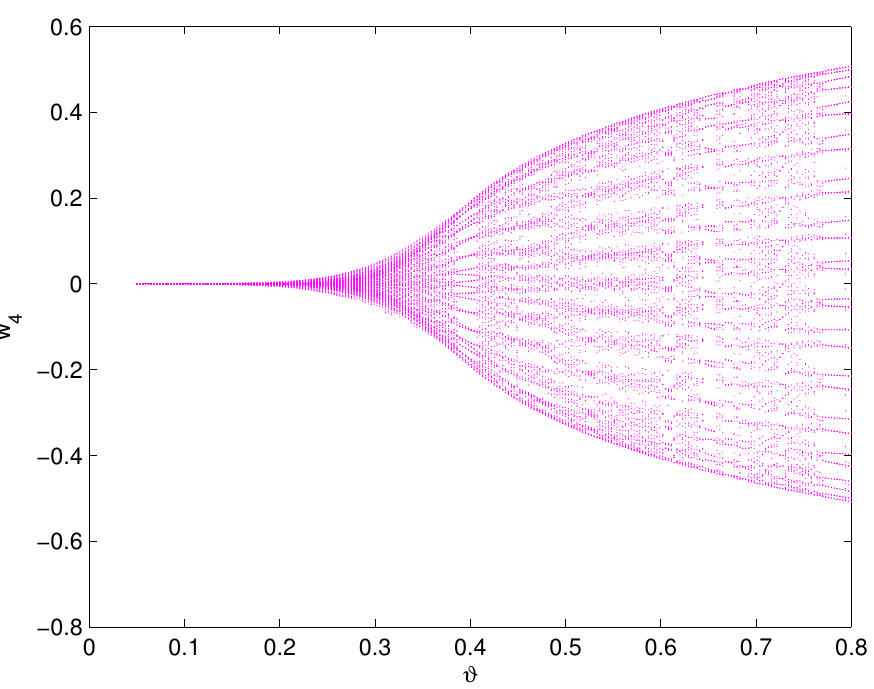
Figure 6. Bifurcation graph of system (71): the delay ϑ versus the variable w 4 . The bifurcation number is 0.37.